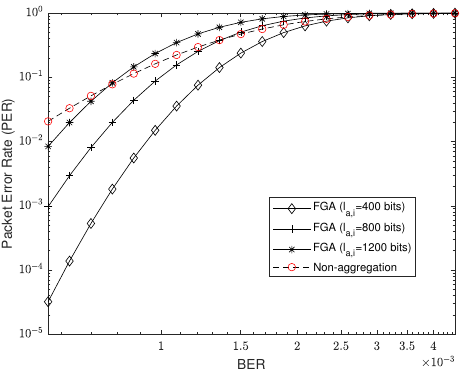
Figure 5. PER against increasing BER for different total length l a , i of packets that can be aggregated to the i th packet with l i of 800